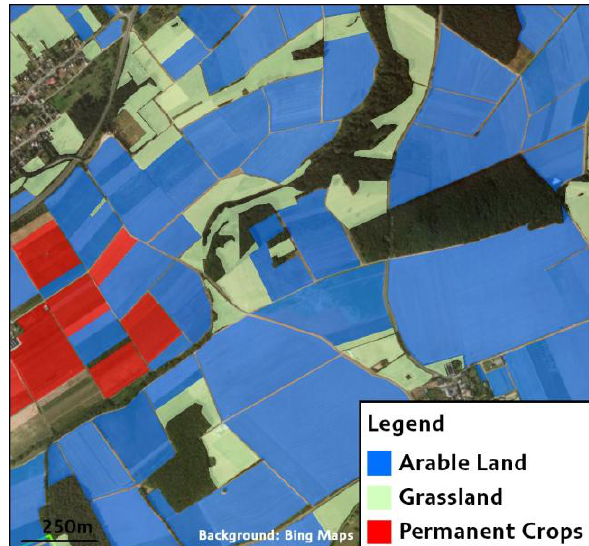
Figure 3. ‘Field block’ vector data for Germany. (Data source: Landwirtschaftskammer NRW,